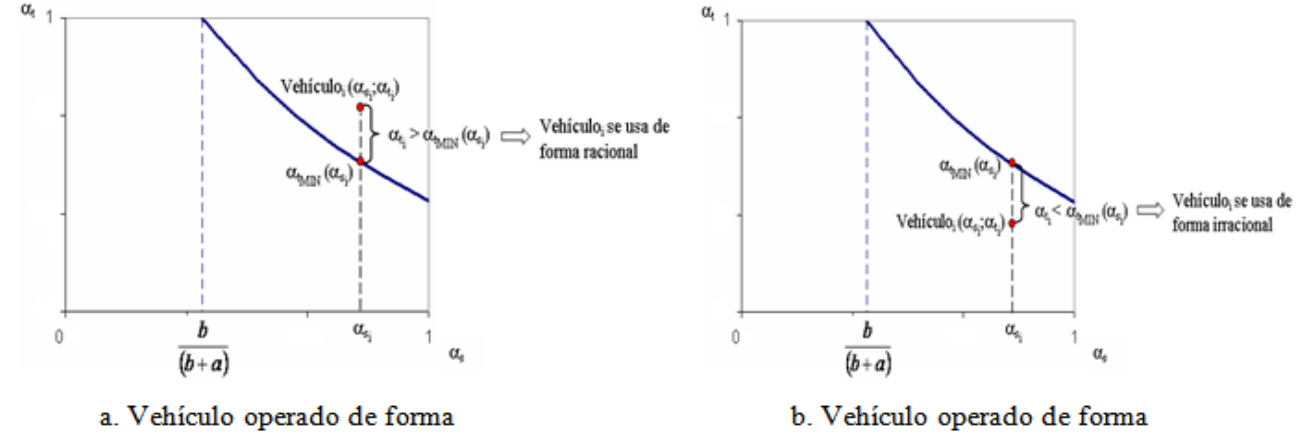
Figura 3. Condiciones para la identificación de los vehículos operados de forma racional e irracional. Fuente: Los autores,